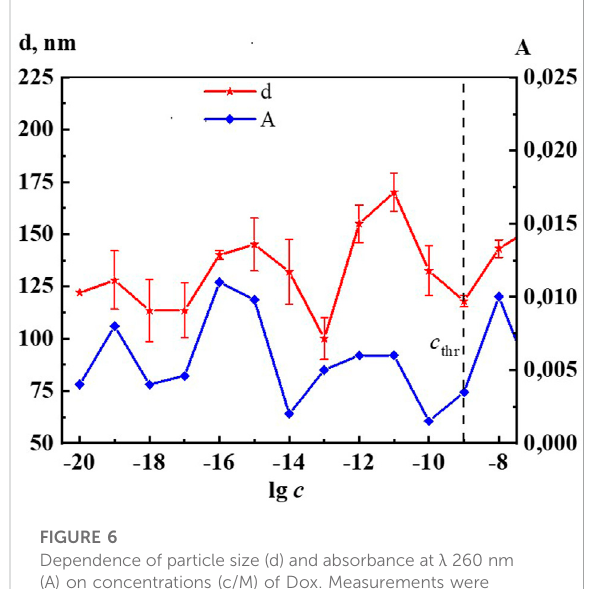
FIGURE 6 Dependence of particle size (d) and absorbance at λ 260 nm (A) on concentrations (c/M) of Dox. Measurements were performed at 25 ± 0.1 ° C. The dotted line indicates the threshold concentration ( c thr ).